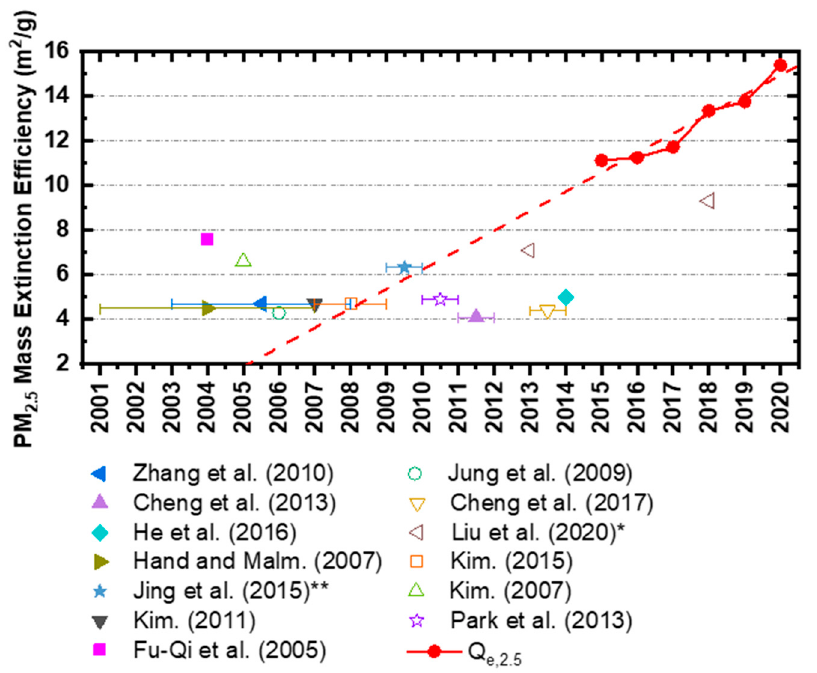
Figure 8. Comparison of Q e,2.5 values from this and previous studies at wavelength 550 nm. * Used wavelength 589 nm. ** Used wavelength 525